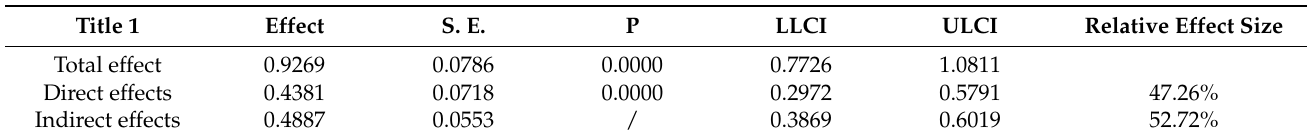
Table 3. Mediating effect of learning satisfaction in the association between effort-reward imbalance and academic burn-out.